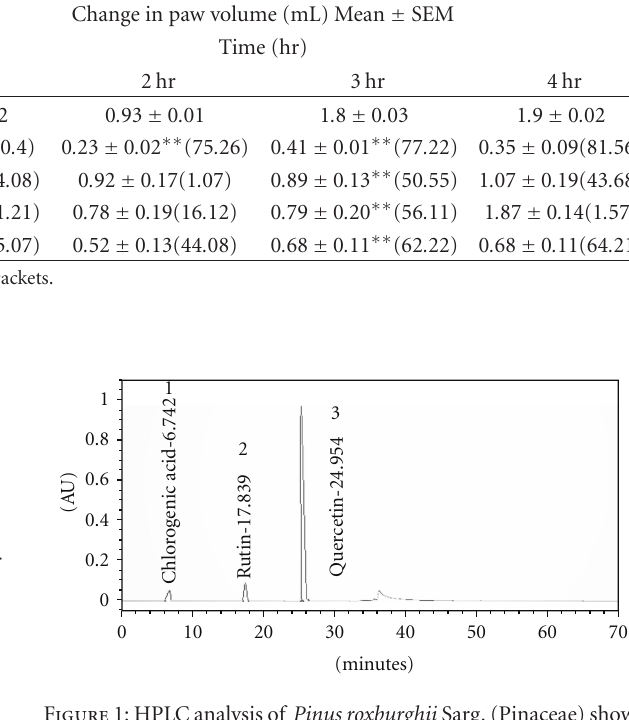
taken before carrageenan injection and then 1, 2, 3, and 4 h after carrageenan injection. The alcoholic extract of Pinus